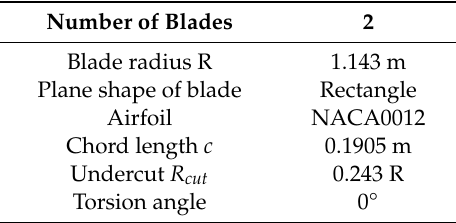
Table 1. Detailed parameters of C-T rotor.